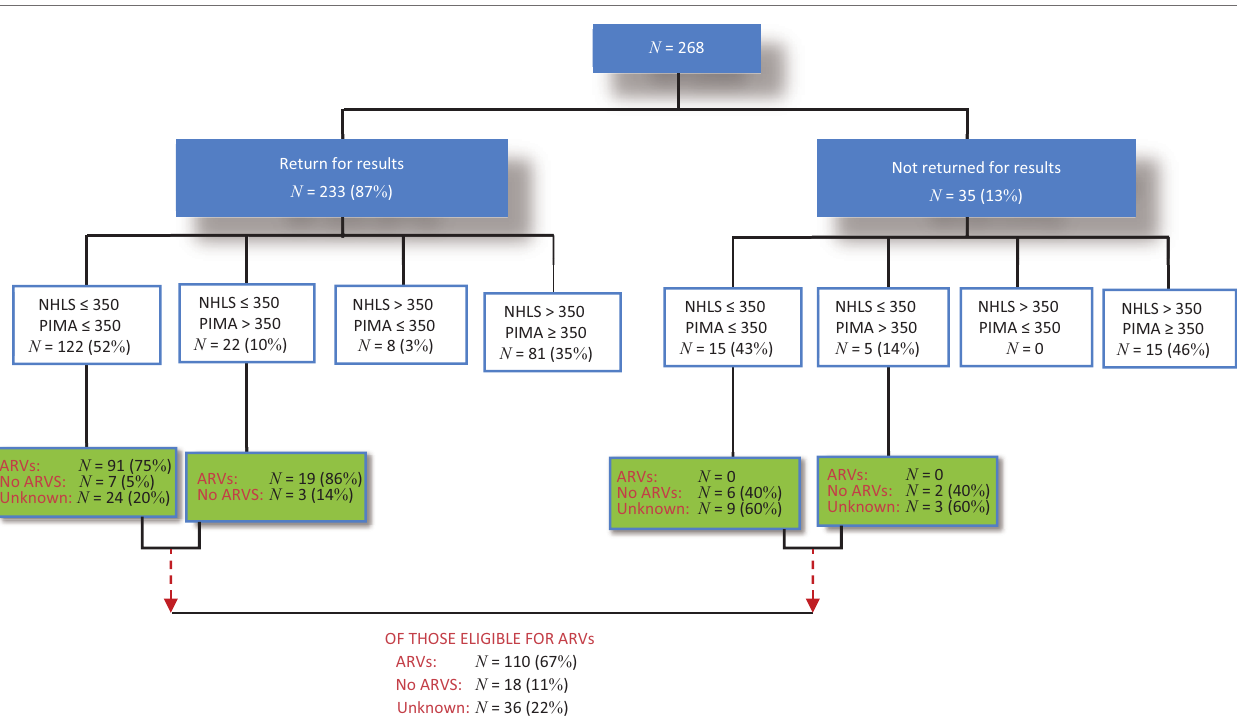
FIGURE 3: Comparison of CD4+ T-cell counts with respect to antiretroviral therapy eligibility by PIMA TM point-of-care analyser versus National Health Laboratory Services in those HIV-1-infected patients who returned and did not return for their results.